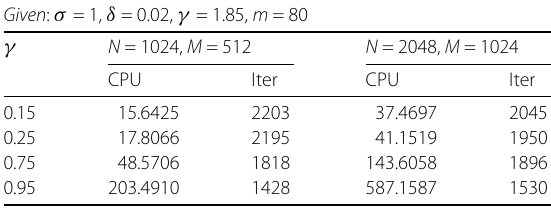
Table 3 The convergence of Algorithm 3.1 with each